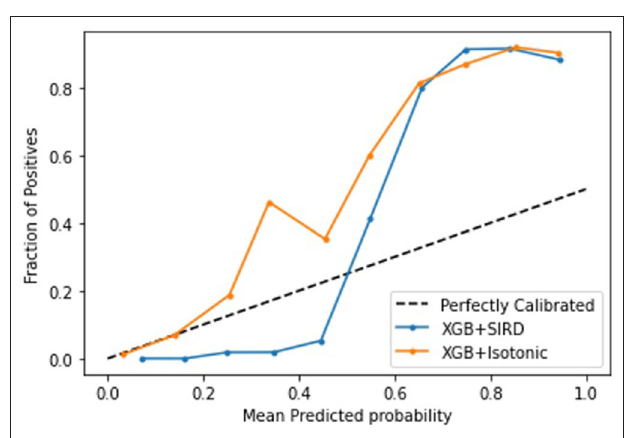
FIGURE 8 | XG Boost classifier calibration graph for class 1.